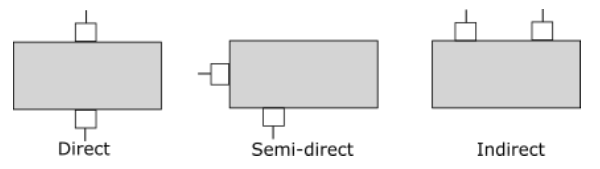
Figure 2. UPV transducer arrangements.